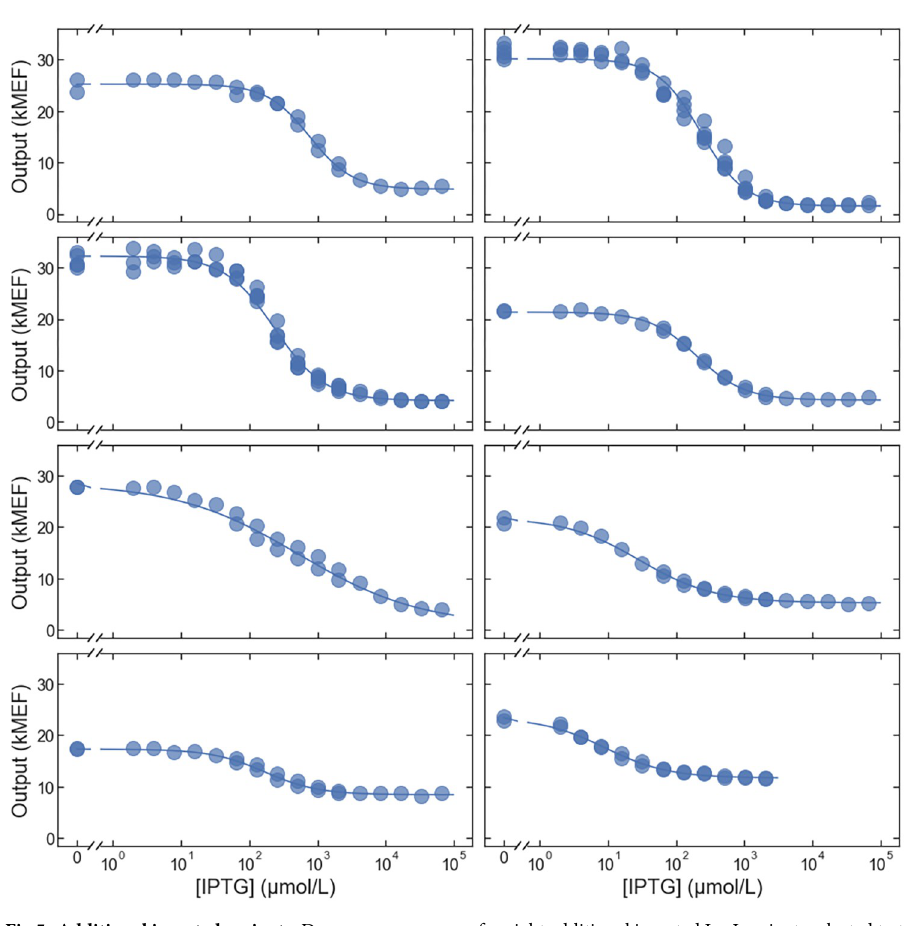
Fig 5. Additional inverted variants. Dose-response curves for eight additional inverted LacI variants selected to test the accuracy of the large-scale measurements.